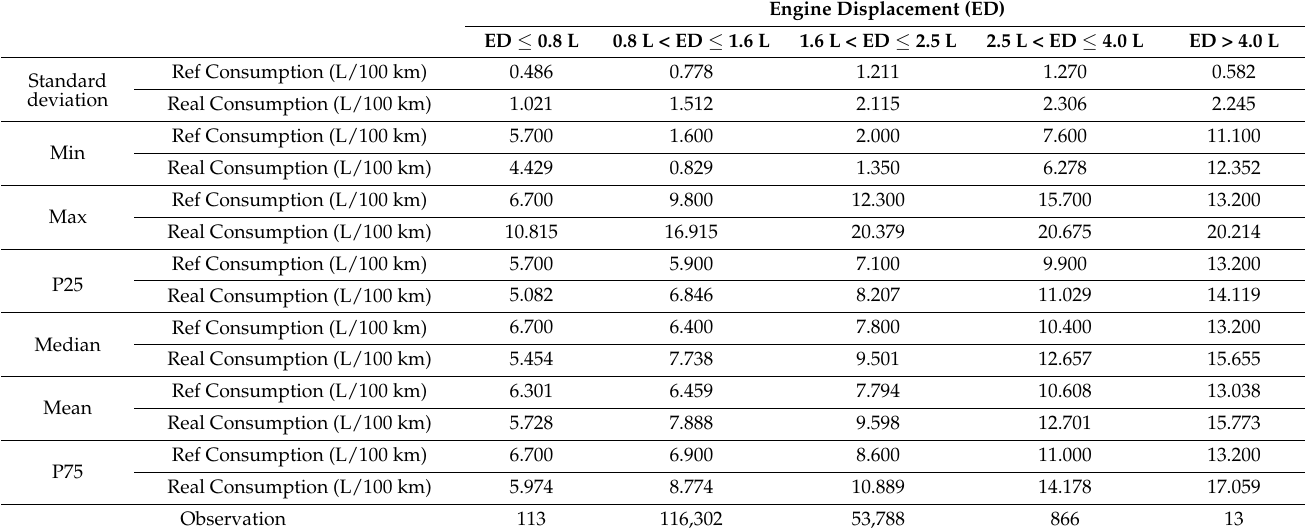
Table 2. Distribution of fuel consumption